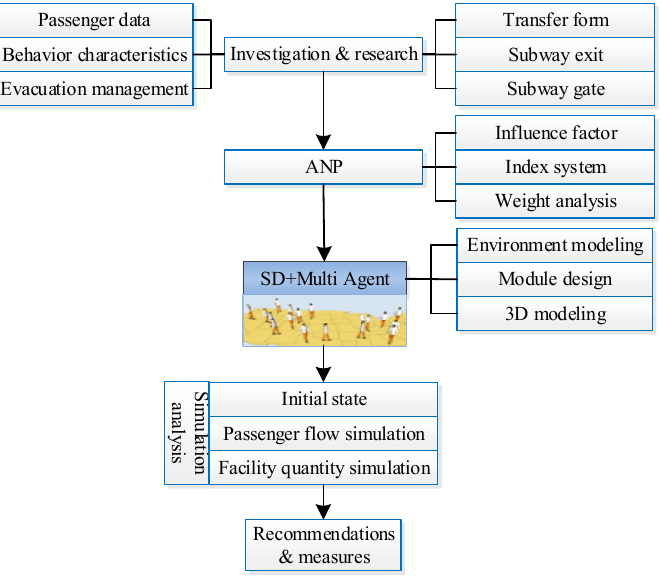
Figure 2. Research process.